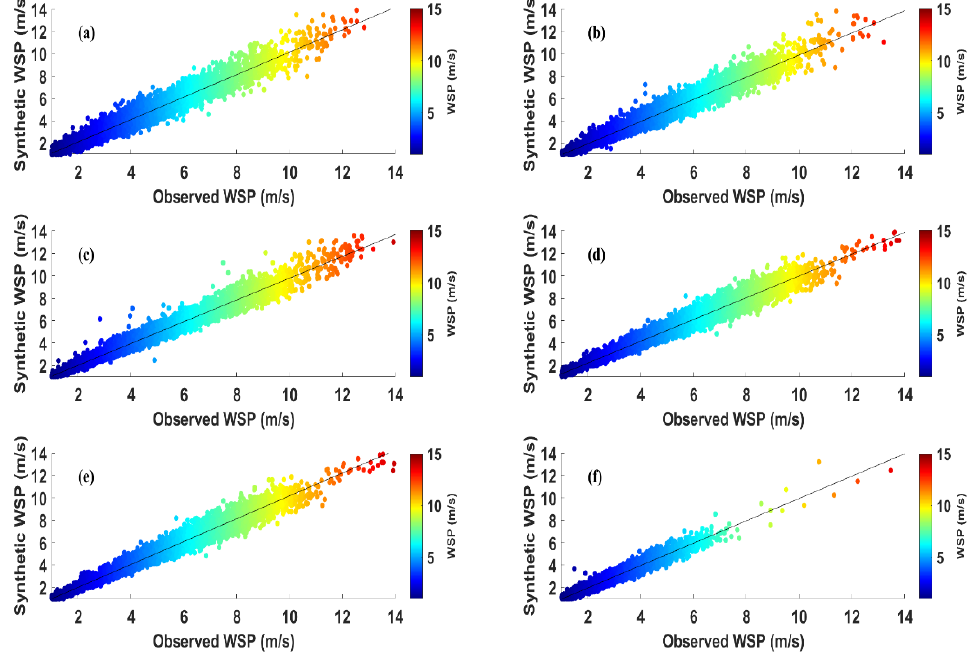
Figure 5. Scatterplots of LSTM-generated and NDBC-observed significant wave heights (m) for buoys ( a ) 42056, ( b ) 42057, ( c ) 42058, ( d ) 42059, ( e ) 41046, and ( f ) 41047.